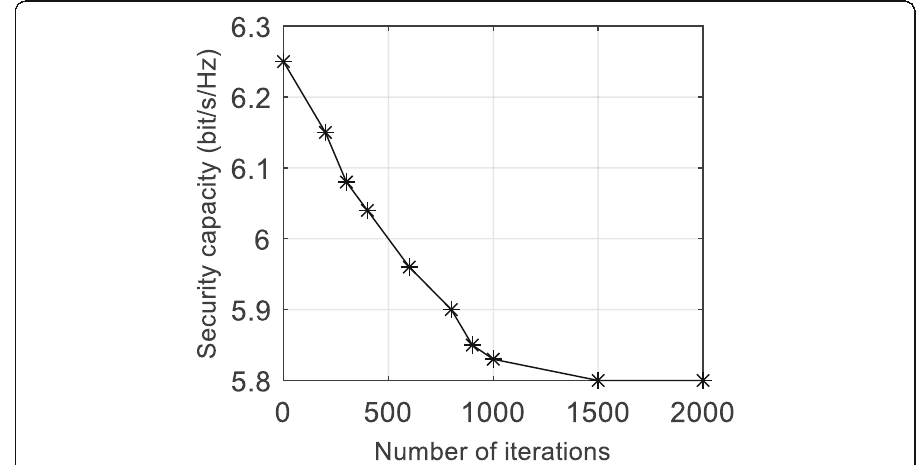
Fig. 5 The security capacity varies as the number of iterations changes. y -axis represents the security capacity achieved by the proposed optimization scheme; x -axis represents the number of